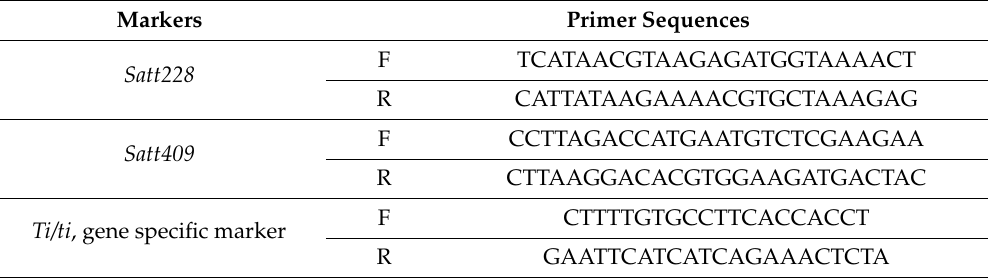
Table 1. SSR markers and corresponding primer sequences used for the identification of soybean Ti3/ti3 genotypes.